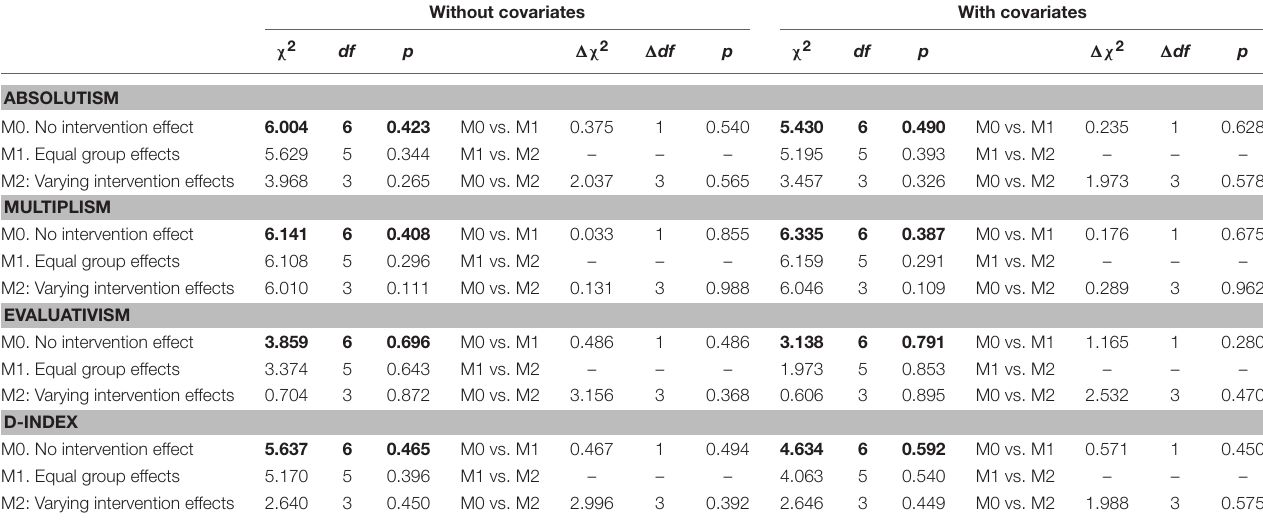
TABLE 5 | Fit indices and model difference tests for the